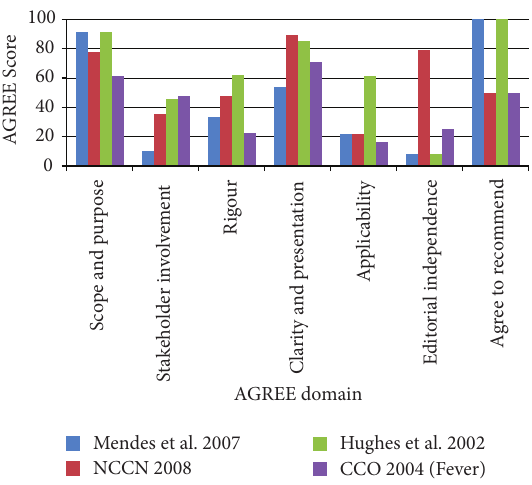
Figure 3: Febrile neutropenia guideline AGREE scores for each of the AGREE domains with higher scores indicating higher quality guidelines ( 𝑛 = 4